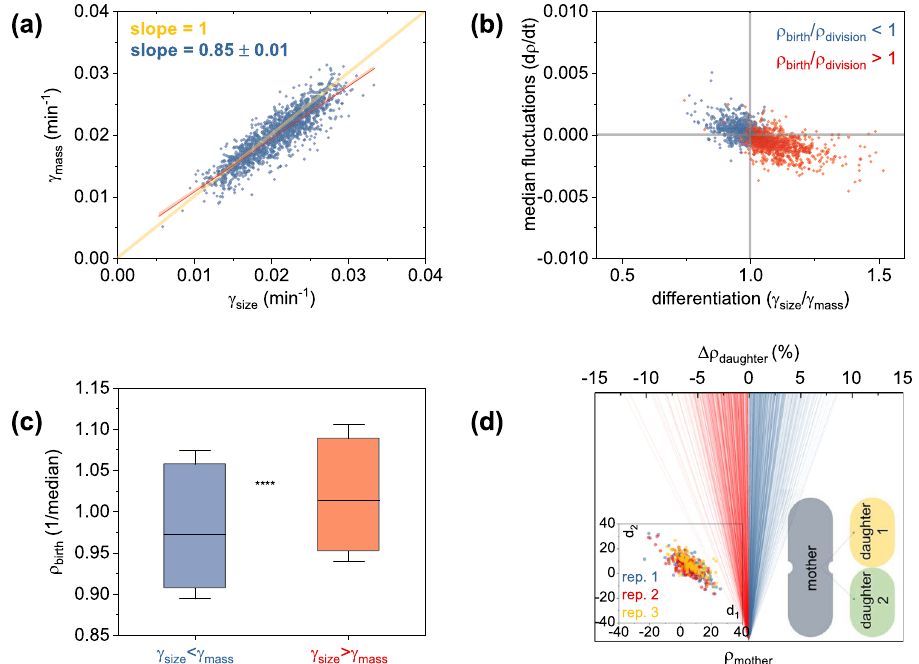
Fig. 2 Single bacteria do not necessarily exhibit identical growth rates in mass and size, and are prone to asymmetric partitioning of biomolecules upon division. a Growth differentiation with some cells maximizing area ( γ size ) and others biomass ( γ mass ) accumulation; graph represents the cumulative response of three replicates, with each replicate presented separately in Supplementary Fig. 4; red line corresponds the linear fi t of the experimental data (shaded areas are the 95% con fi dence intervals) and the yellow line represents a slope of 1. b Median density fl uctuations during growth (d ρ /dt, y- axis) as a function of growth differentiation ( γ A / γ M , x- axis); d ρ /dt were calculated as the median value of all density fl uctuations (namely: d ρ = ρ i + 1 − ρ i in the dt = t i + 1 − t i timeframes — see Methods) during the cell cycle; similarly, the growth rates in cell mass and size were calculated by exponential fi ts throughout the cell cycle, as detailed in the Methods section; color coding corresponds to increased (blue) or decreased (red) density prior to division; graph plots the cumulative response of three replicates, with each replicate presented separately in Supplementary Fig-. 5. c Growth differentiation ( γ A / γ M ) dependence on cellular dry-density at birth (normalized over the median); boxcharts represent the 25 – 75% of the combined three replicates with each replicate plotted separately in Supplementary Fig. 6; whiskers display the 20 – 80% range and asterisks denotes statistical signi fi cance (Mann – Whitney test: U = 203746, p < 0.001, with additional statistical tests reported in Supplementary Table 1). In support of this fi nding, we also plot the differentiation dependence on the density at birth in Supplementary Fig. 7a. d Division asymmetry in dry-density, as noted by the density differences ( Δρ daughter %) between each daughter ( ρ daughter-i at birth) to its mother ( ρ mother at division), also displayed in inset. Blue (red) traces correspond to density increases (decreases) upon division, and asterisks denote statistical signi fi cance of nonzero daughter density differences from their mother (One Sample Wilcolxon Signed Rank Test, W = 554931, Z = 28.11, p « 0.001). This graph represents the cumulative response of all biological triplicates, with each replicate